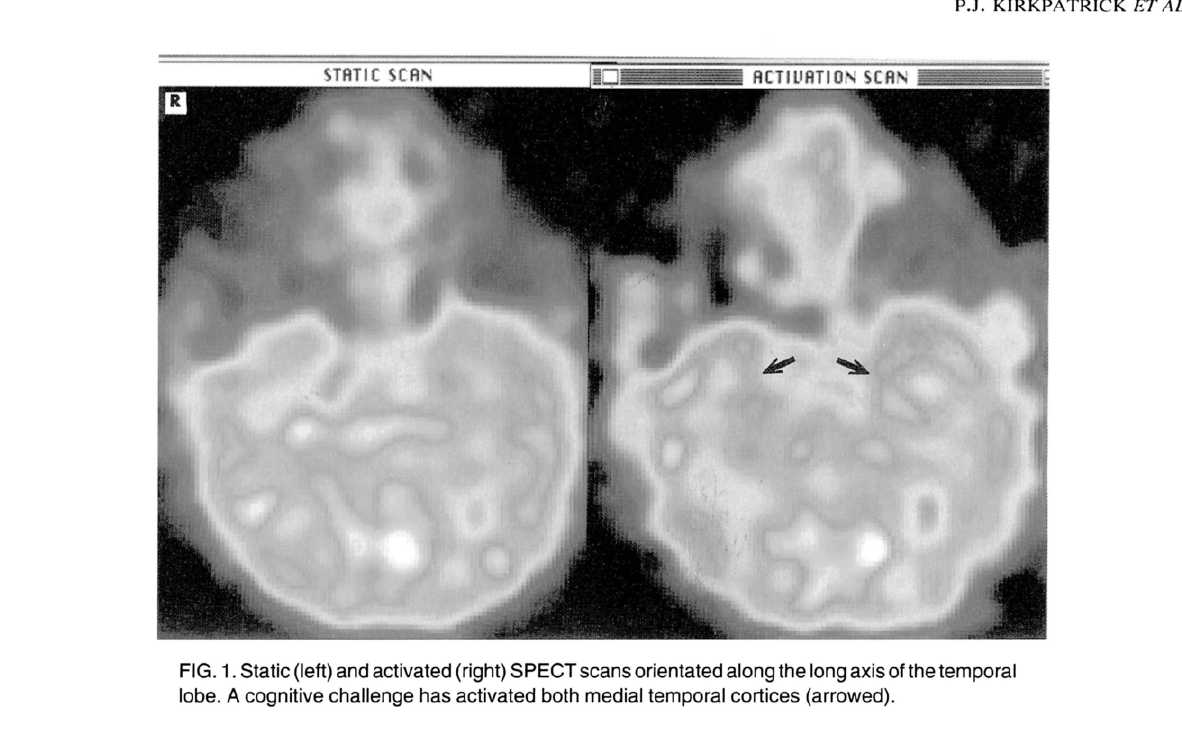
FIG. 1. Static (left) and activated (right) SPECr scans orientated along the long axis of the temporal lobe. A cognitive challenge has activated both medial temporal cortices (arrowed).